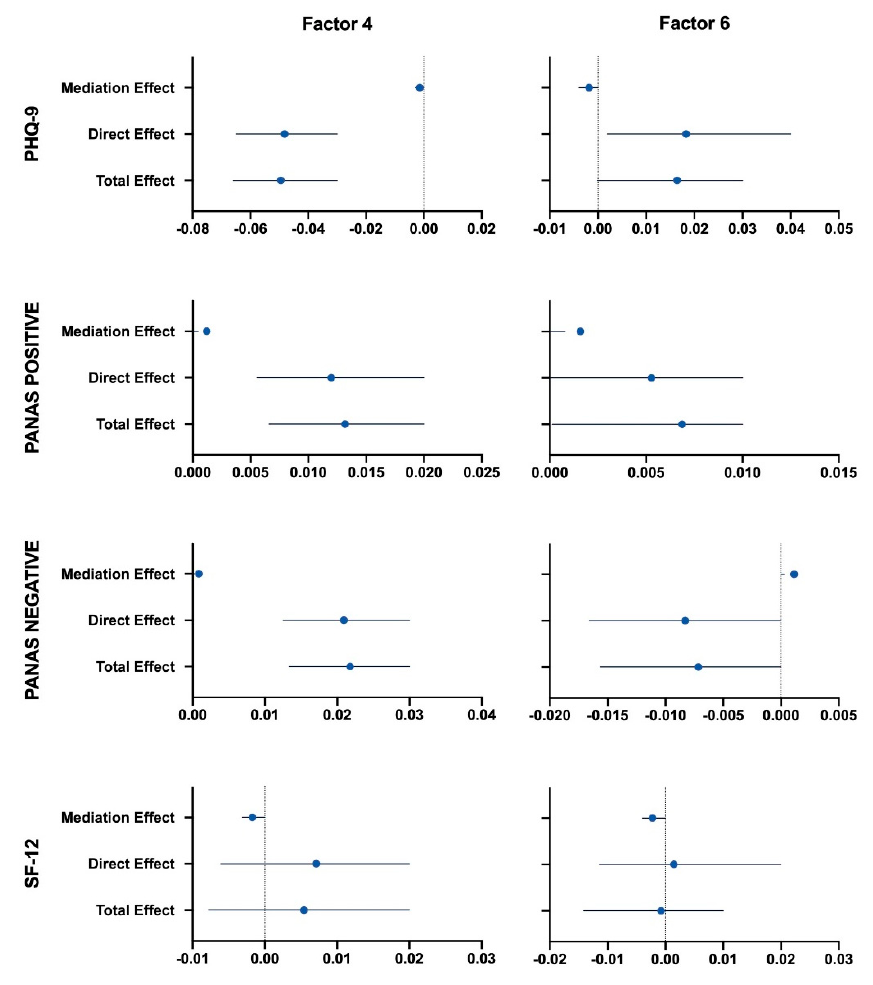
Figure 6. Plots of mediation, direct and total effects of training load on psychometric scales (PHQ-9, PANAS + , PANAS − , SF-12) for Factors 4 (fruit and fresh vegetables) and 6 (fish).